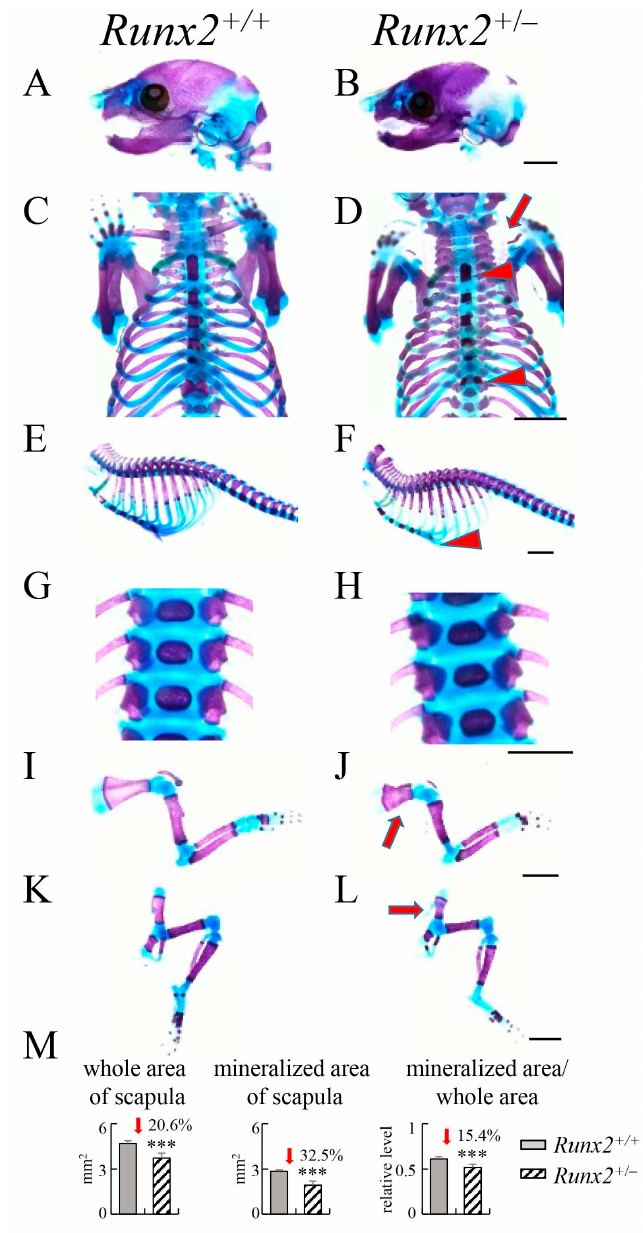
Figure 3. Skeletal development in Runx2 +/+ and Runx2 +/ − newborn mice. ( A , B ) Lateral view of skulls. ( C , D ) Neck and chest. ( E , F ) Lateral view of ribs and vertebrae. ( G , H ) Enlarged pictures of vertebrae. ( I , J ) Forelimbs. ( K , L ) Hind limbs. The arrow in ( D ) shows hypoplastic clavicle, and arrowheads in ( D , F ) show delayed mineralization of sternum. The arrows in ( J , L ) show delayed mineralization of scapula and pelvic bones, respectively. Scale bars: 0.2 cm. ( M ) Whole area and mineralized area of scapulae and the ratios. Six Runx2 +/+ mice and nine Runx2 +/– mice were analyzed. *** p < 0.001.